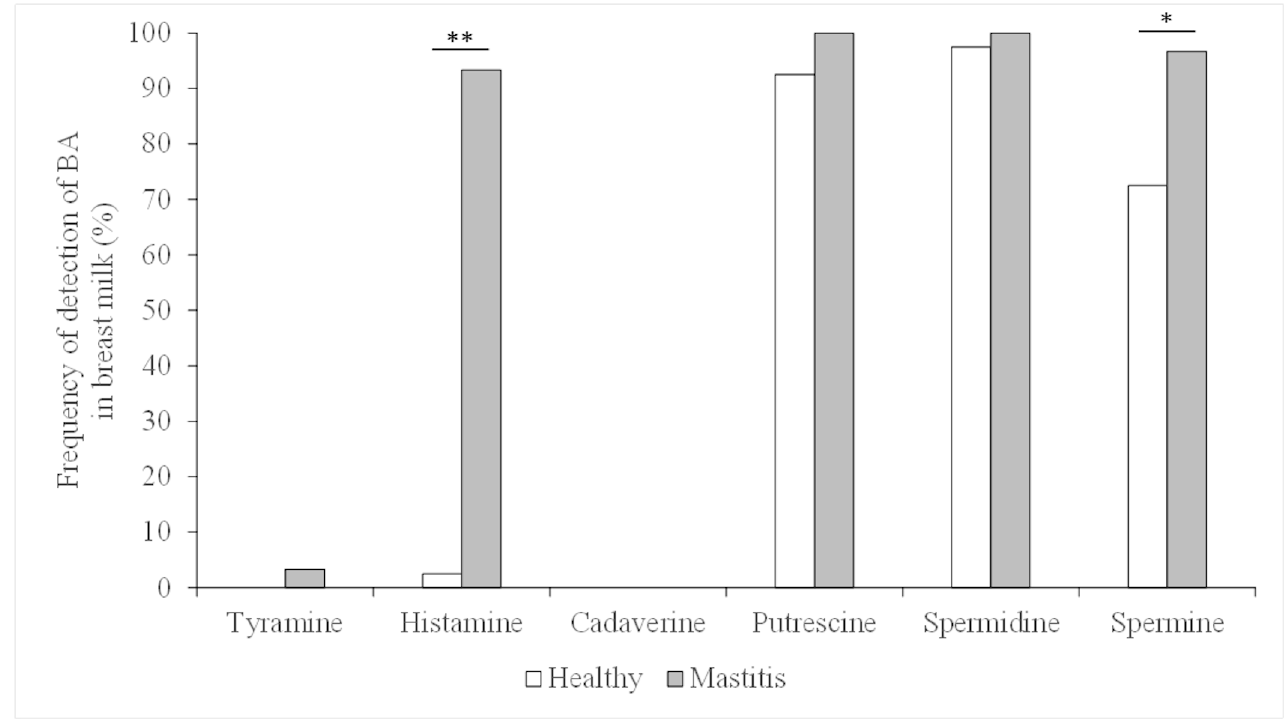
Fig 1. Frequency of detection of BAs in healthy-breast milk (n = 40) and mastitis-affected milk (n = 30). The results of Chi-squared tests to examine the differences in the presence of BAs between the two types of milk are shown by asterisks. * p = 0.0082; ** p <